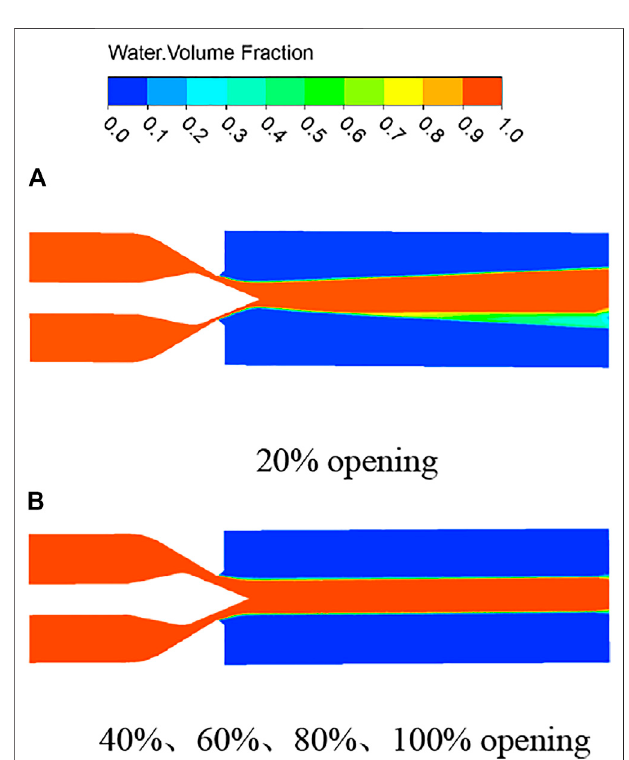
FIGURE 6 | Gas-liquid two-phase cloud diagram of the eccentric jet at different